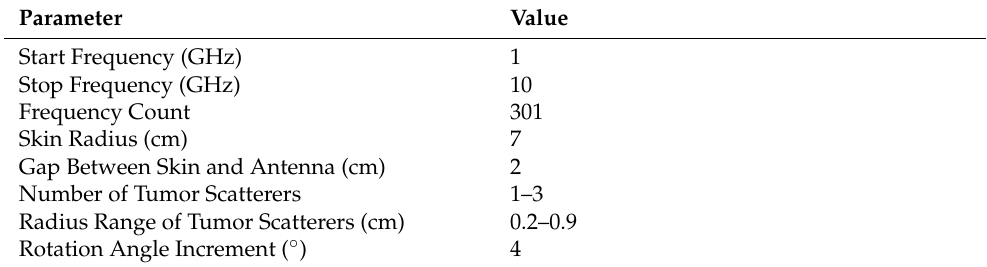
Table 1. Values for simulation parameters.